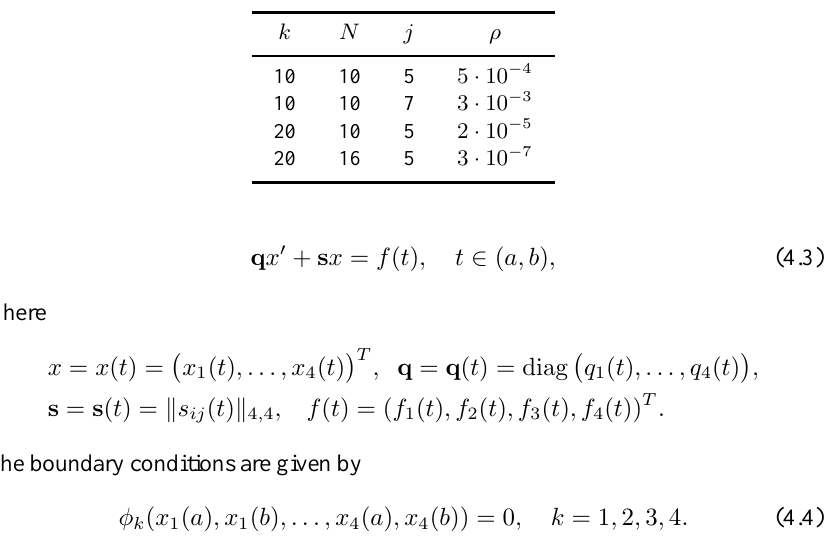
Table 12. Example 3 ( b = 30